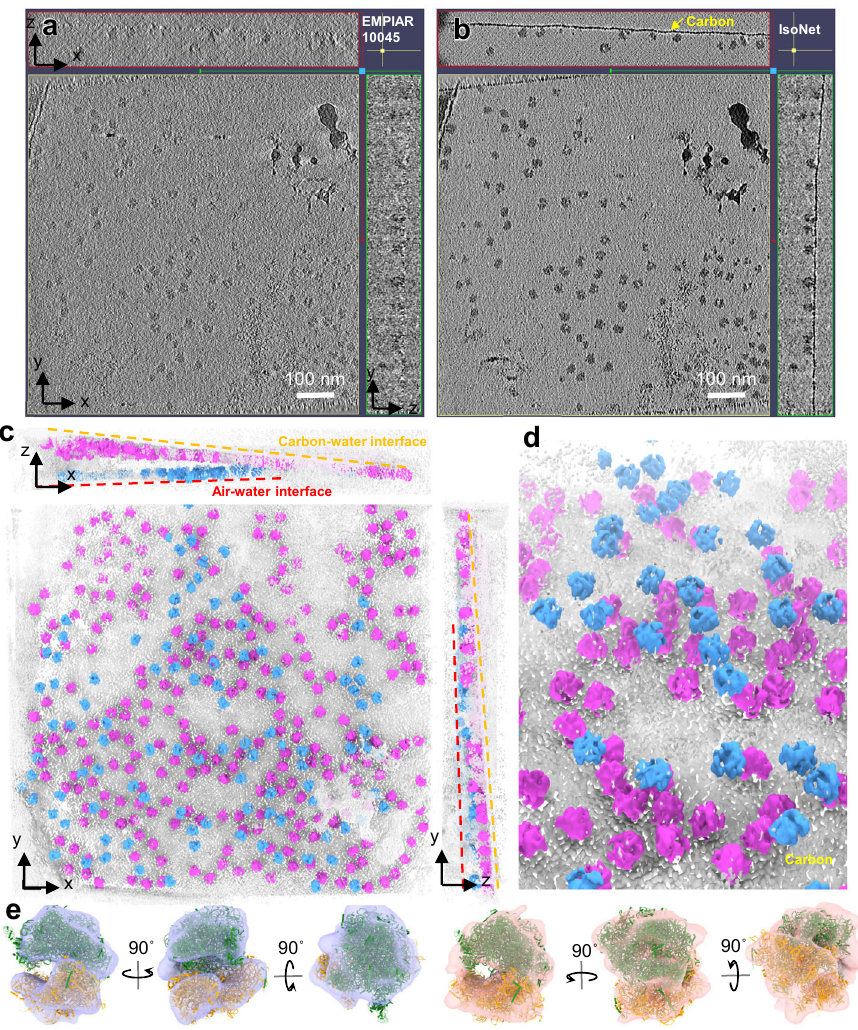
Fig. 2 | IsoNet corrects missing-wedge artifact of ribosome dataset. a , b Orthogonal slices of original ( a ) and IsoNet-processed ( b ) tomograms of iso- lated ribosomes. c 3D rendering of the missing-wedge corrected tomogram. Dashed lines show the air-water or carbon-water interfaces. d Enlarged view of the